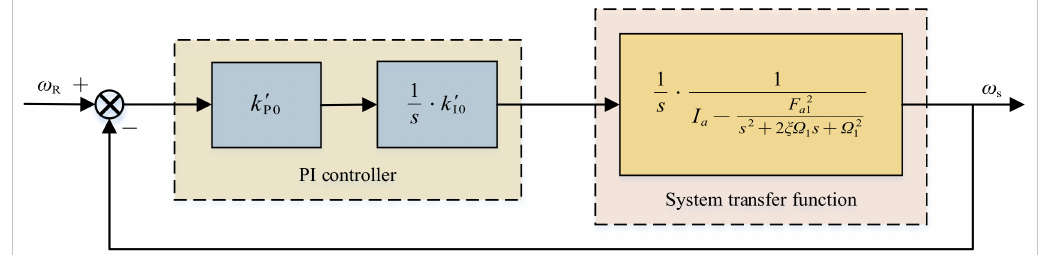
Figure 2. Standard form block diagram of speed loop of a traditional PI control